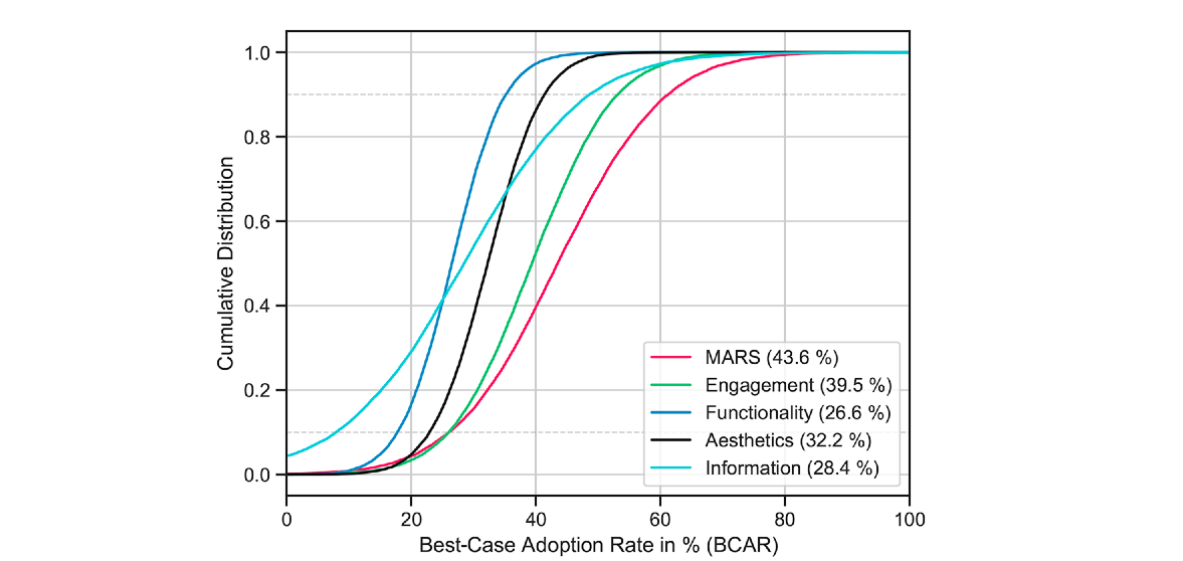
Figure 3. Cumulative distribution of the BCAR; numbers in brackets indicate the mean BCAR for specific app characteristics. BCAR: best-case adoption rate; MARS: Mobile App Rating